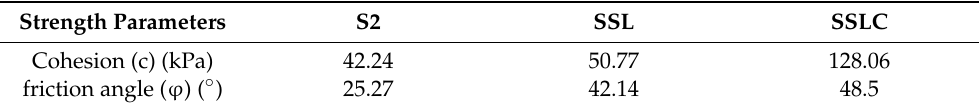
Figure 10. The relationship curve of (s,t). Table 3. Strength parameters of test soil.